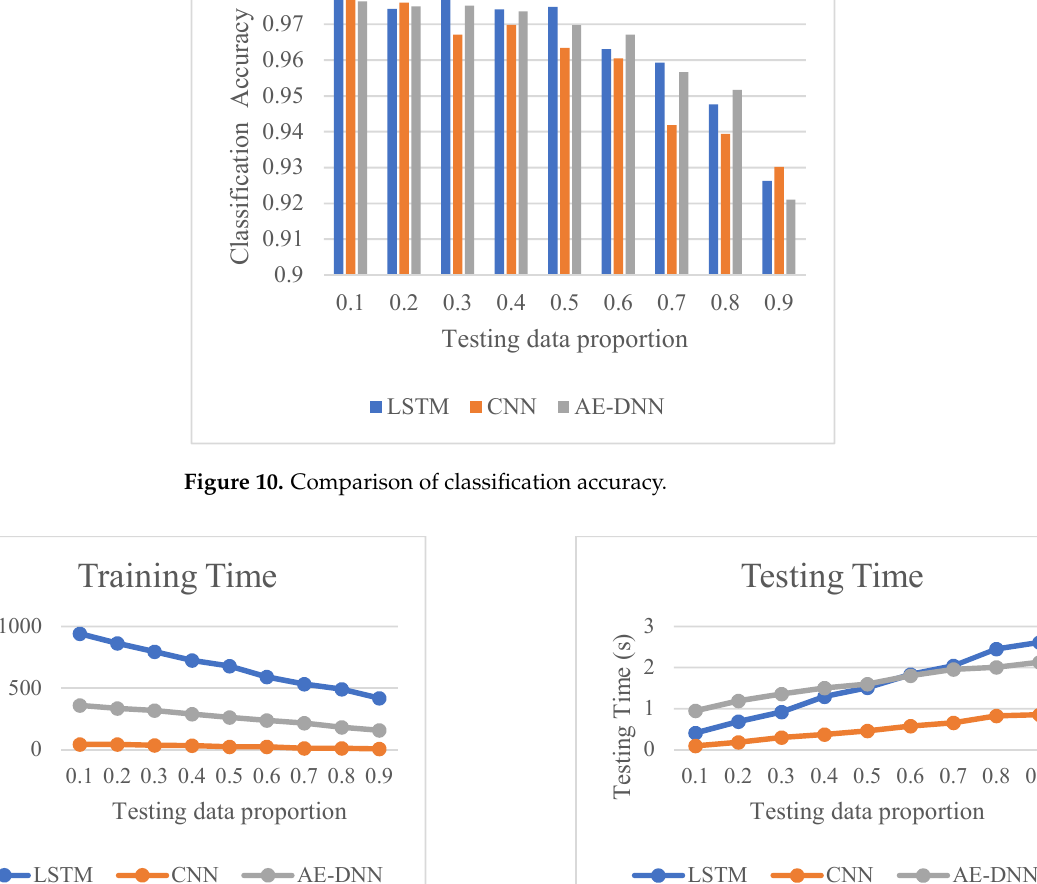
Figure 11. Comparison of computation time for the three methods. ( a ) Comparison of training time spent by the three methods, and ( b ) Comparison of testing time spent by the three methods.